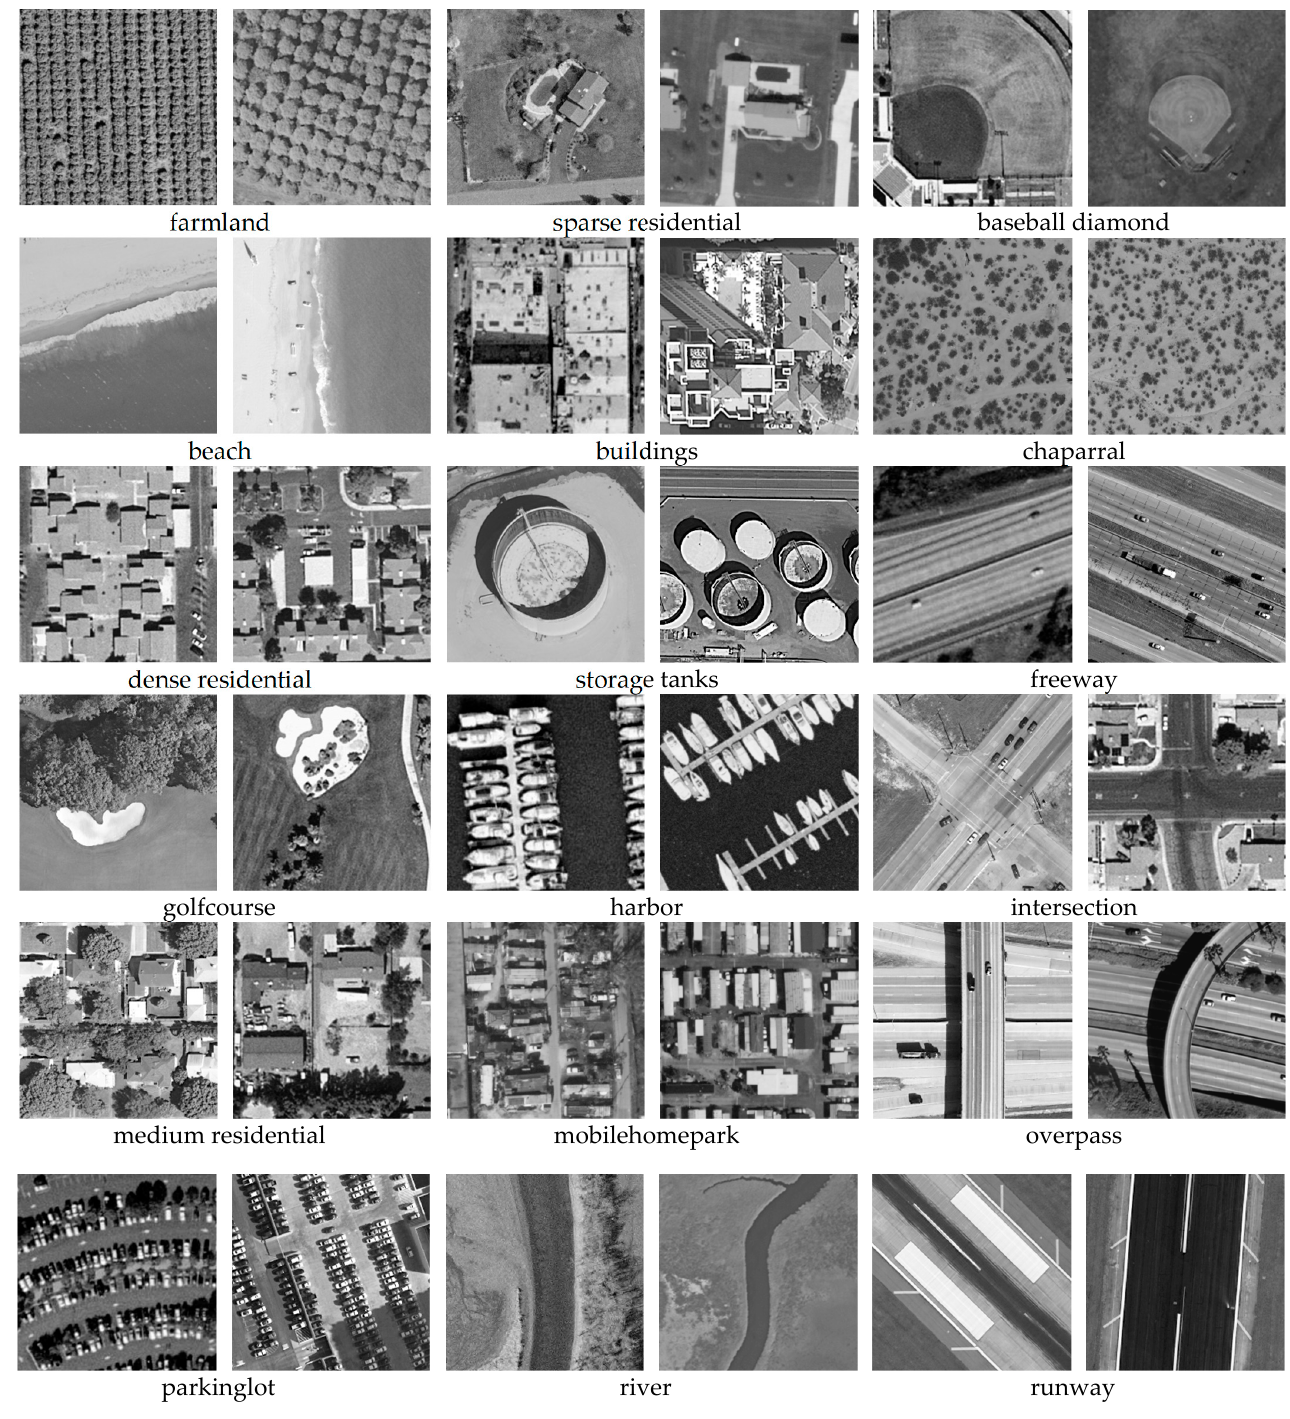
Figure 4. In total, 18 kinds of images from the NWPU-RESISC45 dataset in different situations were selected as training sets, including farmland, sparse residential, baseball diamond, beach, buildings, chaparral, dense residential, storage tanks, freeway, etc.